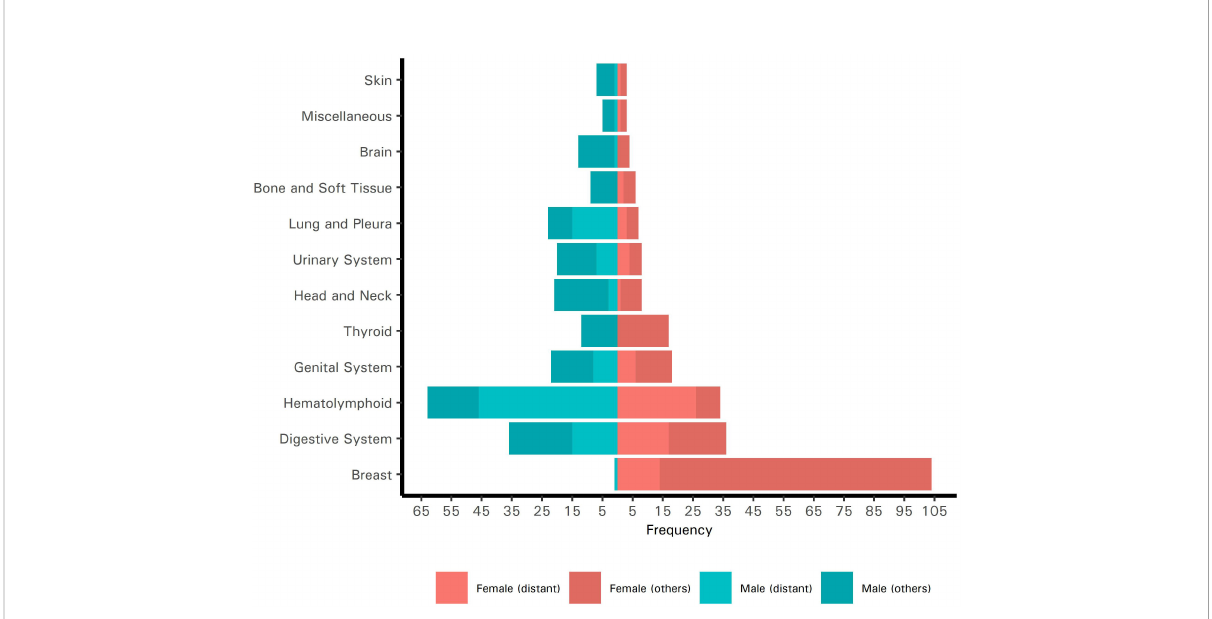
FIGURE 1 Pyramid plot of the site-speci fi c frequencies of cancers in Palestinian patients who presented to King Hussein Cancer Center in 2018 and 2019 ( N = 480) strati fi ed by sex. The frequencies of cancers with distant metastases are